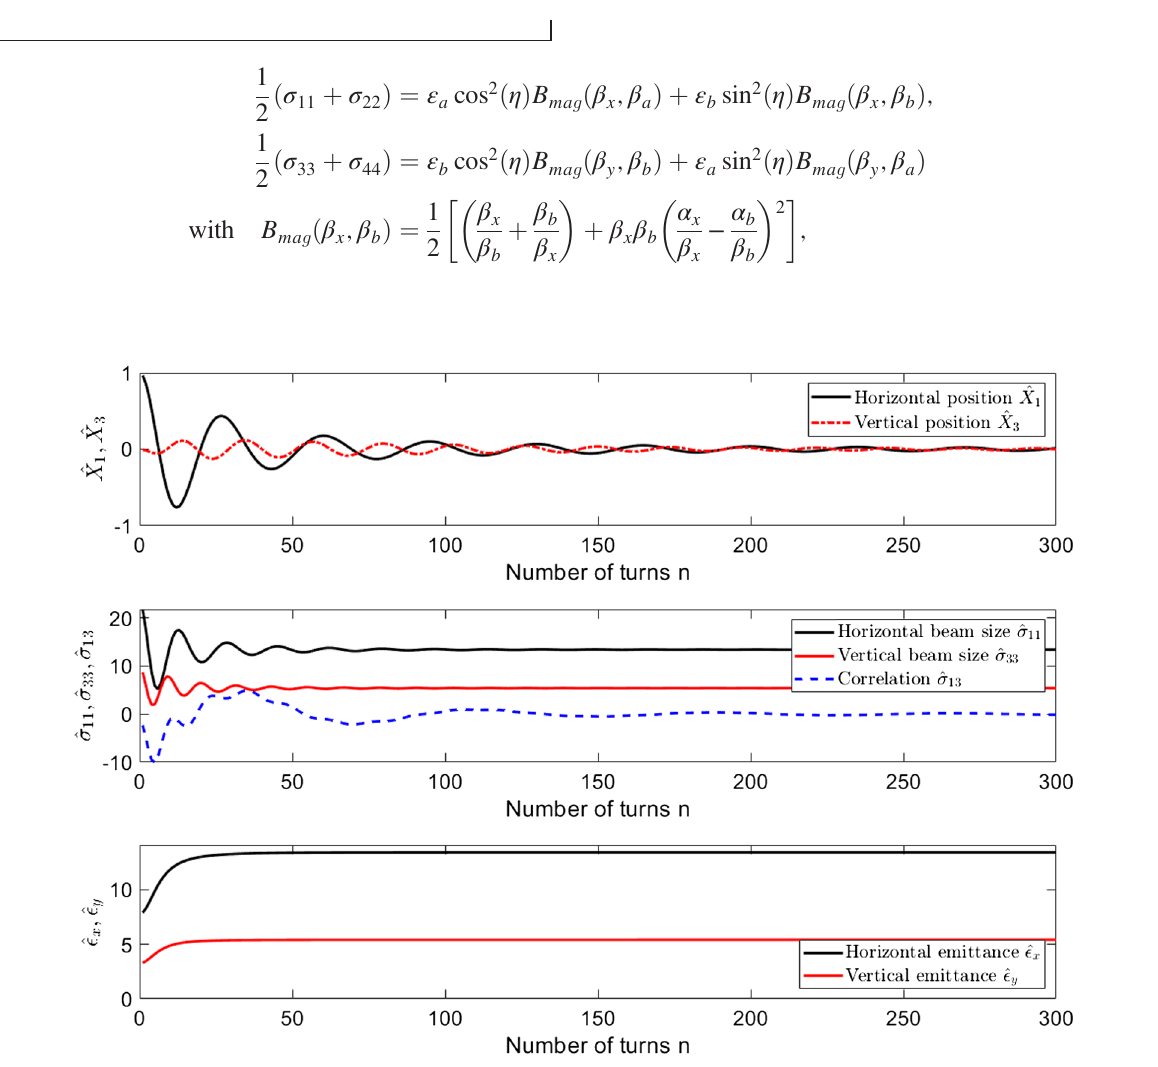
ˆ X ˆ X 1 and 3 (top), beam matrix elements (middle), and emittance (bottom) as a 10 , initial beta mismatch, and displacement. The beam is = ε a b ¼